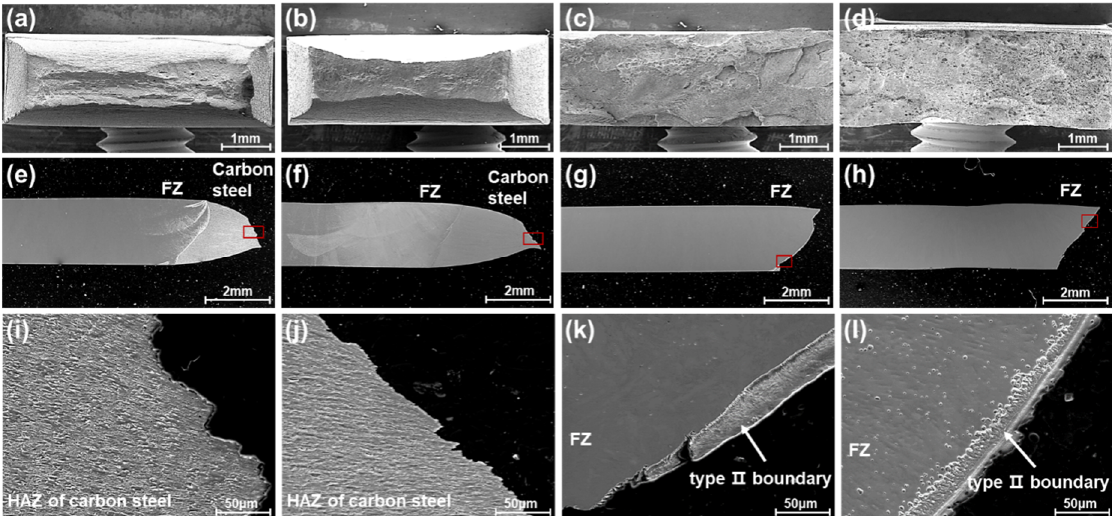
Figure 6. Field-emission scanning electron microscopy (FE-SEM) fractographs of the WJs after the SSRT: ( a – d ) overview of the fractured specimen, ( e – h ) cross-sectioned fracture surface, ( i – l ) magnified fractographs of the red boxes in Figure 6e–h, respectively; ( a , c , e , g , i , k ) DF, ( b , d , f , h , j , l ) AF, ( a , b , e , f , i , j ) under HF and ( c , d , g , h , k , l ) HC conditions.